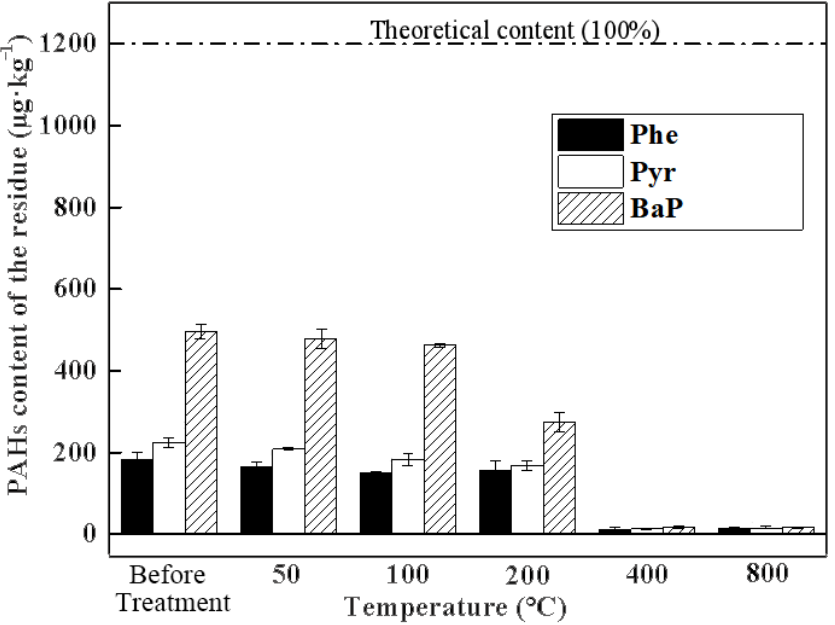
Figure 2. Efficiency of PAH removal from soil using tube furnace.